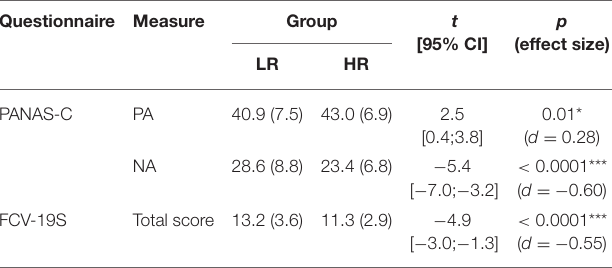
TABLE 6 | Differences in the low-resilience (LR) and high-resilience (HR) profile groups. Questionnaire Measure